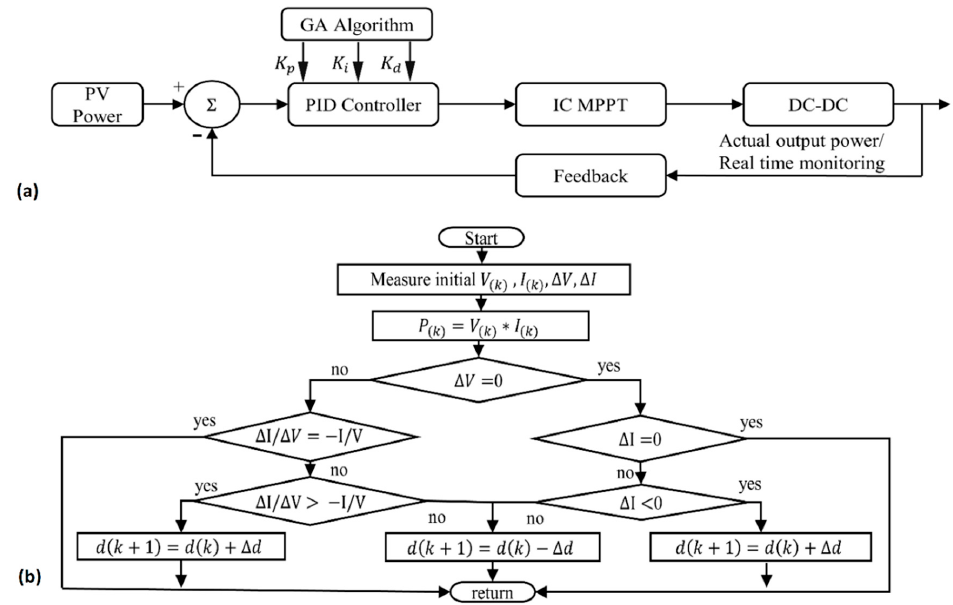
Figure 5. ( a ) Generalized block diagram of the proposed system, ( b ) detailed IC flowchart.